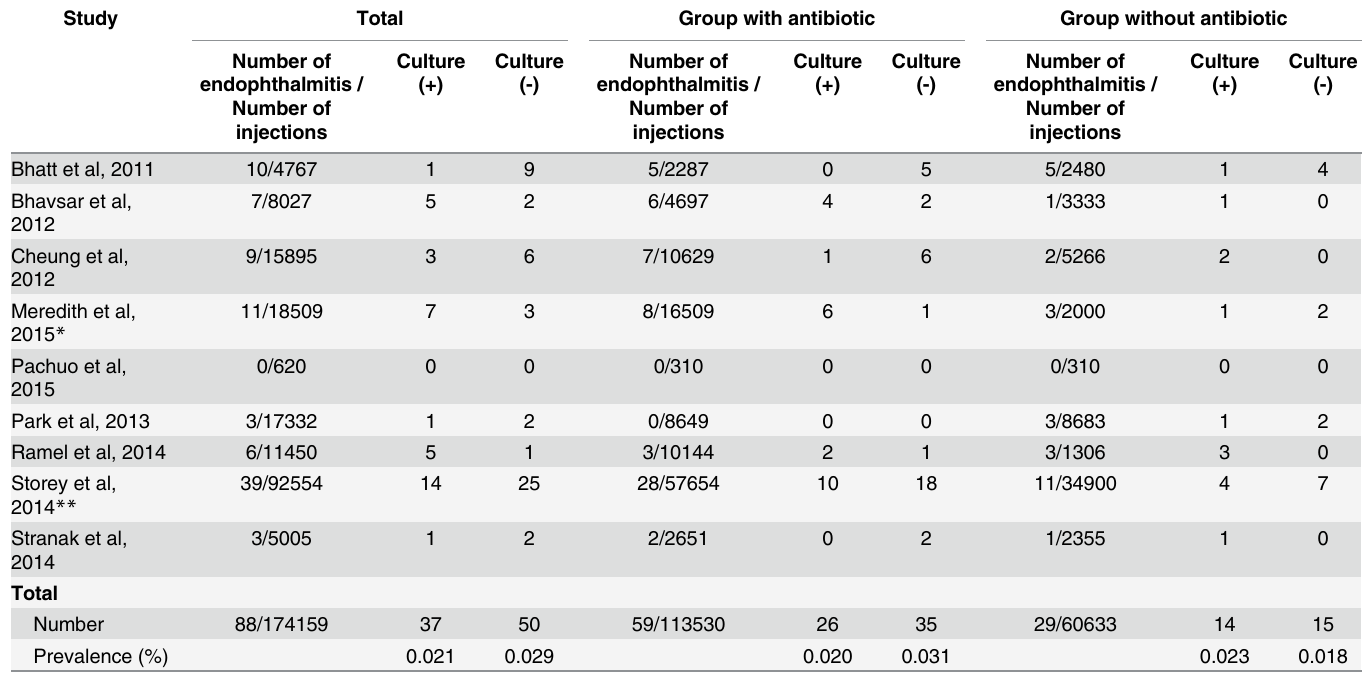
Table 1. Repartition of culture in the 2 groups in each study and prevalence of endophthalmitis in each